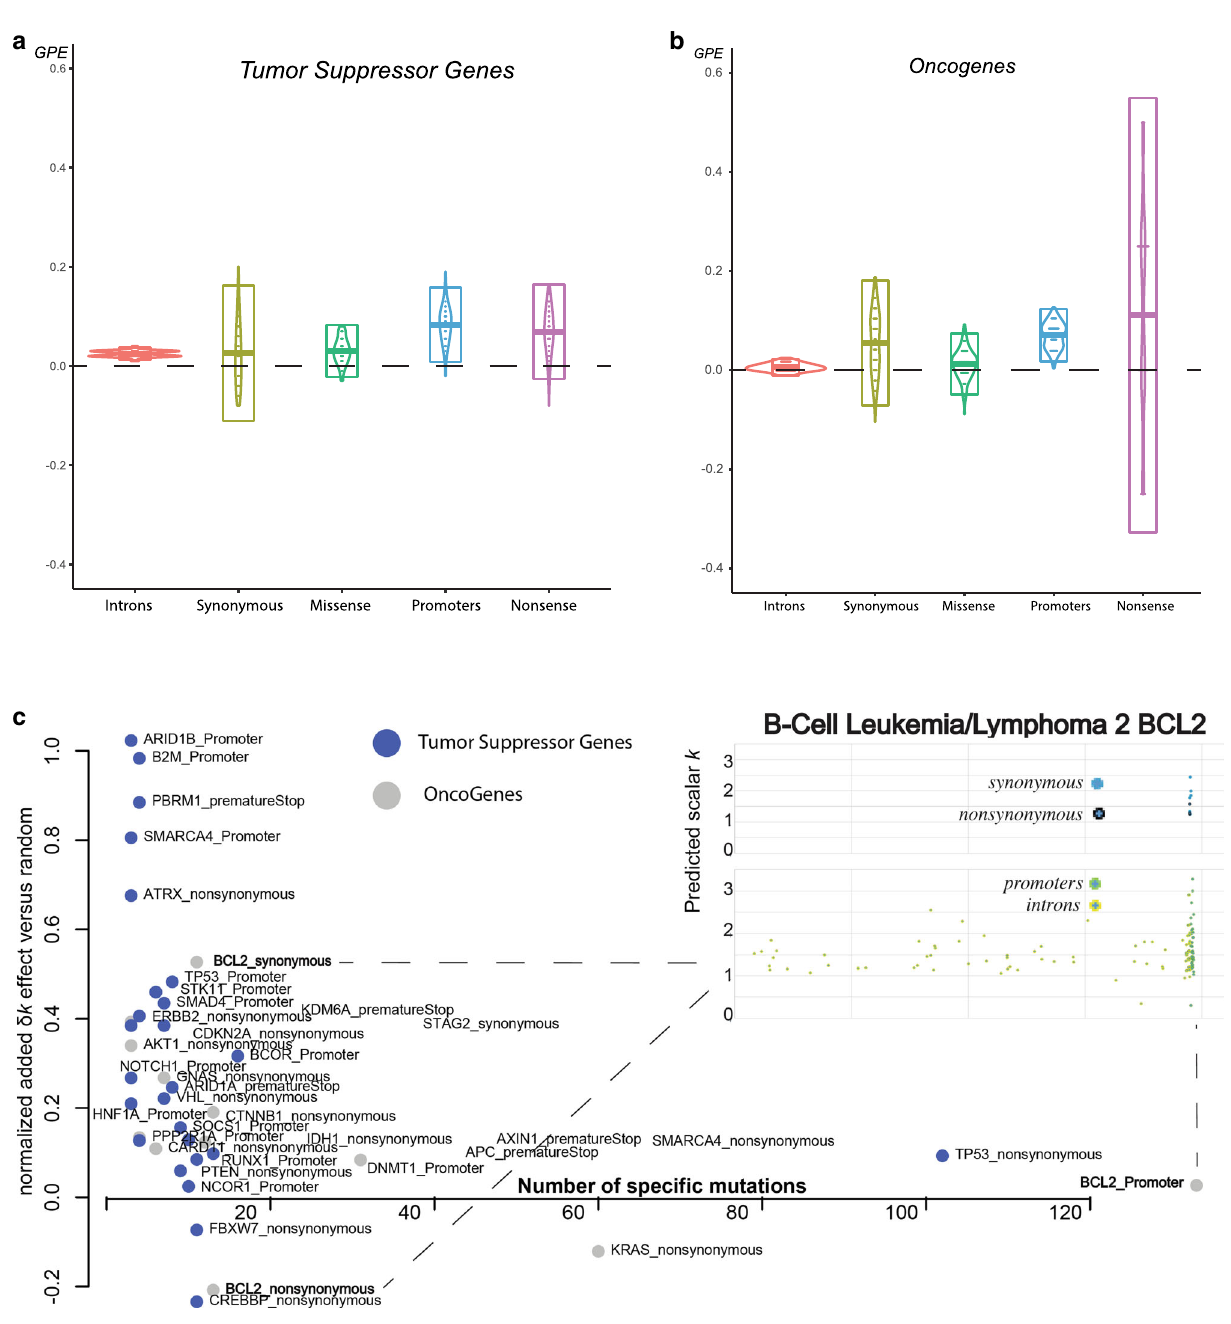
Fig. 4 Tumor-suppressor gene and oncogene elements show growth enrichment. We show the positive growth enrichment across different mutation types (introns, synonymous, missense, nonsense, and promoters). For a , Vogelstein tumor suppressor genes and b Vogelstein oncogenes, boxplots represent 2 × σ deviation, lines represent the mean, while violin plots are trimmed to data range. In c , we plot gene elements (e.g., {GeneX_mutation type}) from Vogelstein gene list that showed signi fi cant positive or negative enrichment. We further zoom in to BCL2 ’ s genomic region to map missense, nonsynonymous, promoter, and intronic indicate an evolutionary transition during tumor progression from multi-cell functionality to single-cell selection.